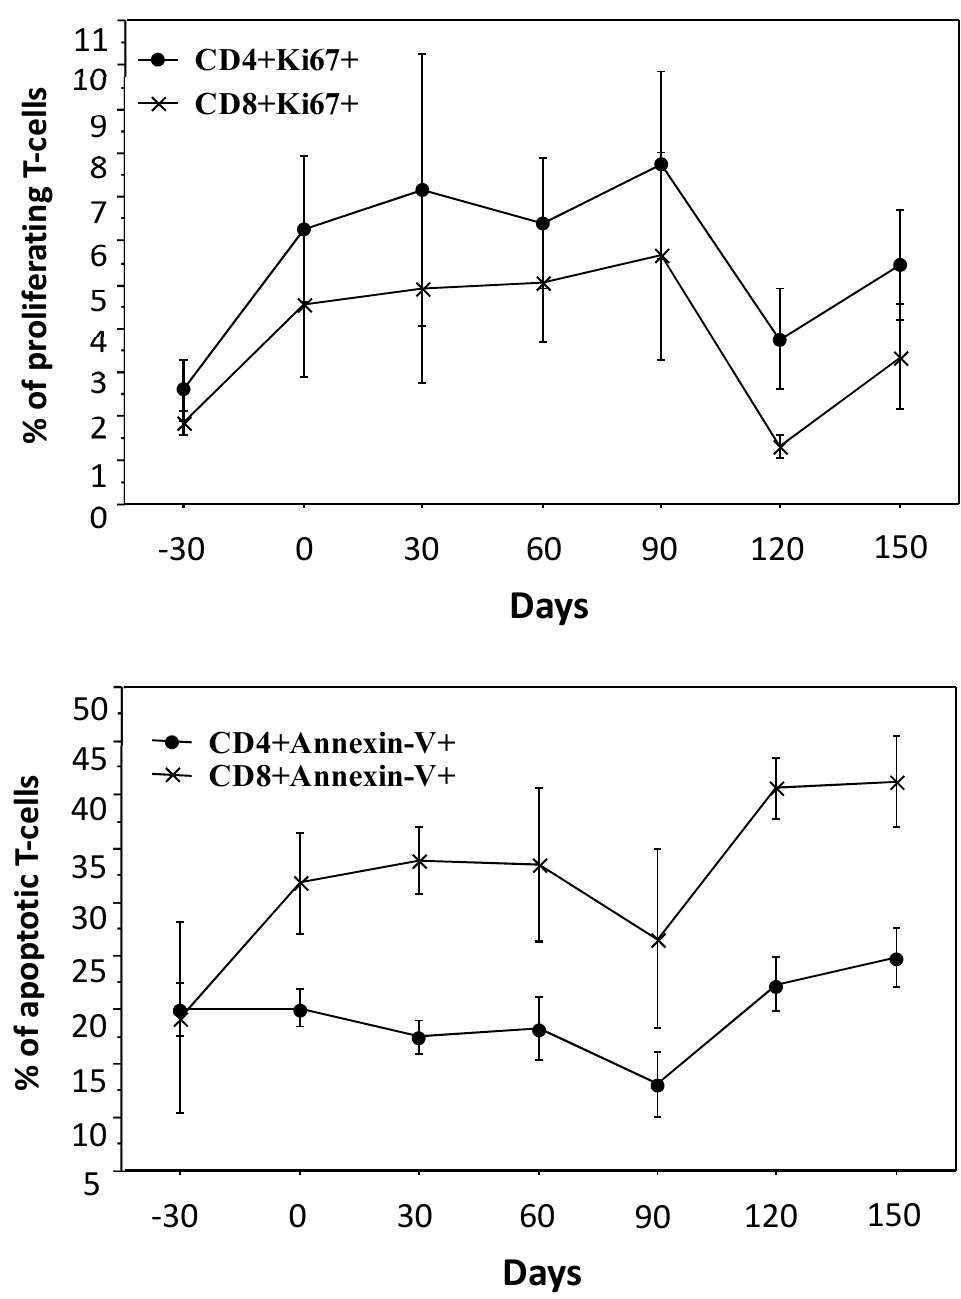
Figure 3. Kinetics of T-cell proliferation and T-cell apoptosis. Raltegravir inclusion had clearly 2 different effects on T-cell subsets. For CD4 T-cells, RLT allowed both a slight increase in proliferation, measured using the Ki67 marker, associated with a trend towards lower apoptosis in CD4 T-cells, measured using the Annexin-V marker. Regarding the CD8 T-cell subset, both markers were increased. It should be noted that raltegravir interruption induced bumpy modifications in the percentage of T-cell